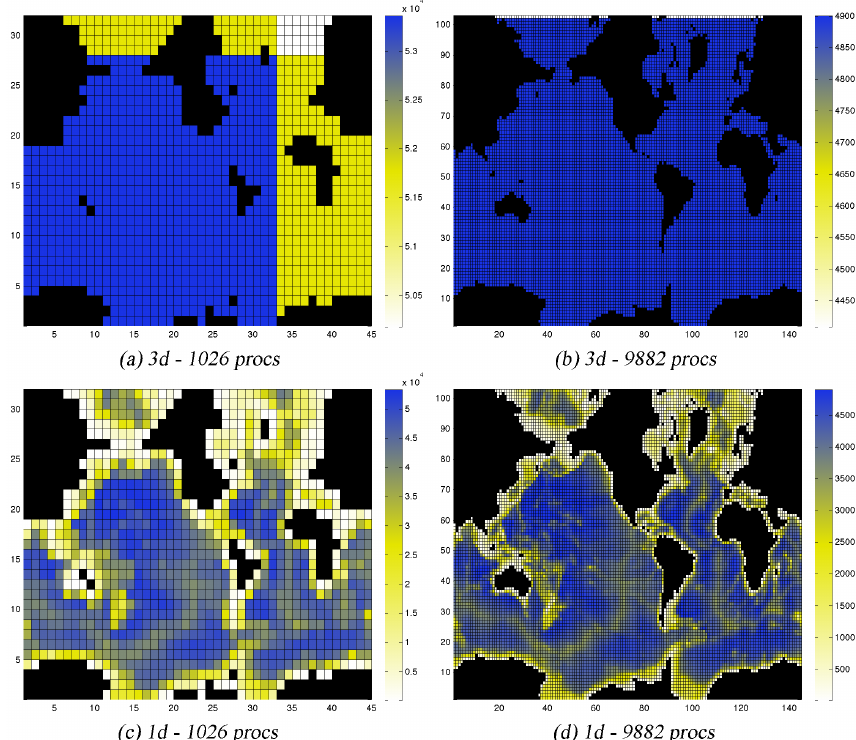
Figure 10. Load balancing for one-dimensional (c, d) and three-dimensional (a, b) data structures with 1026 (a, c) and 9882 (b, d) processors. The colours represent the number of points in the domain.